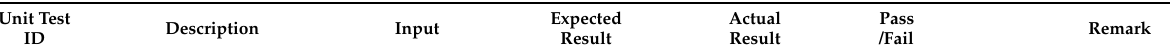
Table A4. Unit testing cases of showing a 3D model of one use of the chemical compound when directing the camera toward its two main chemical